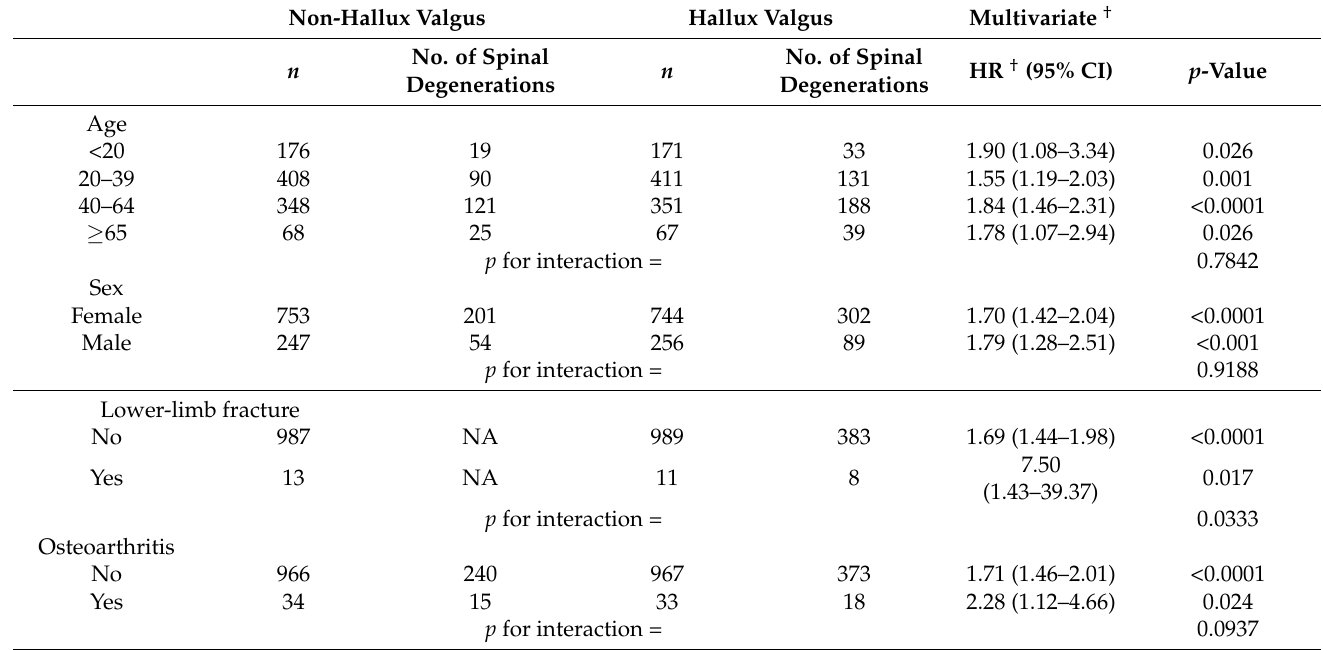
Table 4. Subgroup analysis for risk of spinal degeneration among the hallux valgus and non-hallux valgus